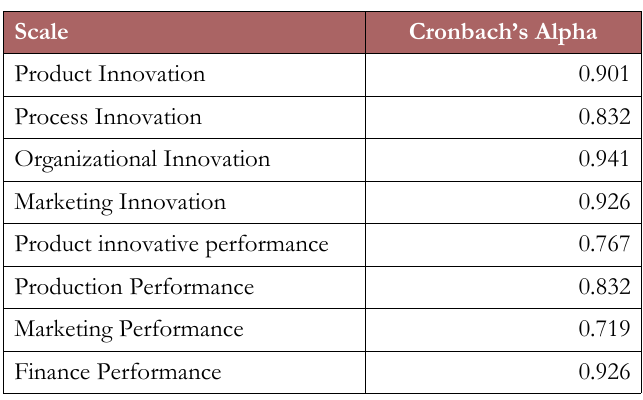
Table 1. Reliability analysis